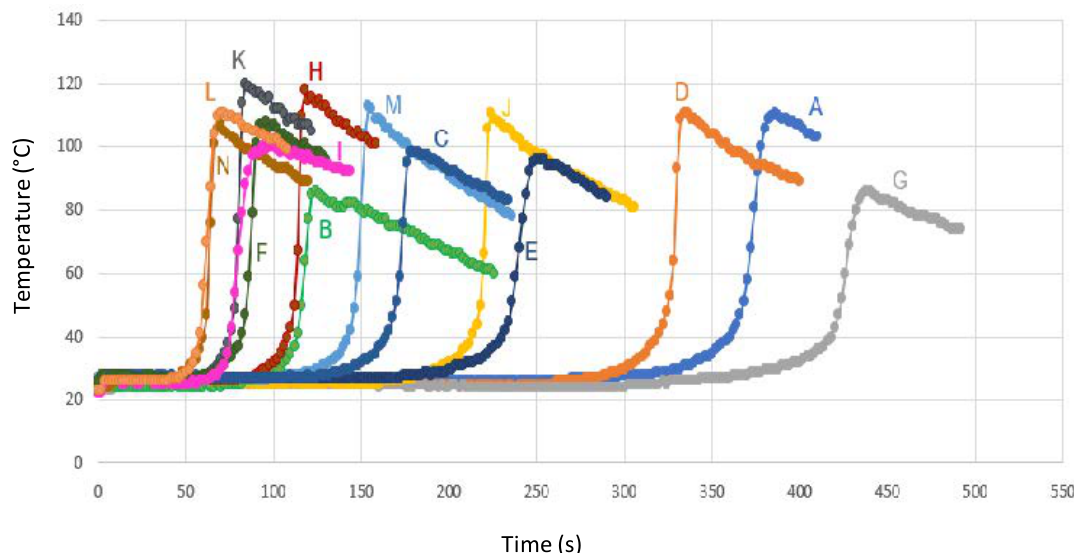
Figure 1. Optical pyrometric measurements (temperature vs. time after mixing; 4 mm thick sample) under air for the BM resin for Redox free radical polymerization (FRP) using different RISs: ( A ) T4epa/Iod (0.5%/1% w/w ); ( B ) T4epa/Iod (1%/2% w/w ); ( C ) T4epa/Iod (2%/0.5% w/w ); ( D ) T4epa/Iod (0.5%/1.5% w/w ); ( E ) T4epa/Iod (1.5%/0.5% w/w ); ( F ) T4epa/Iod (2%/1% w/w ); ( G ) T4epa/Iod (1%/0.5% w/w ); ( H ) T4epa/Iod (1.5%/1% w/w ); ( I ) T4epa/Iod (2%/1.5% w/w ); ( J ) T4epa/Iod (1%/1% w/w ); ( K ) T4epa/Iod (1.5%/1.5% w/w ); (L) T4epa/Iod (2%/2% w/w ); ( M ) T4epa/Iod (1%/1.5% w/w ); ( N ) T4epa/Iod (1.5%/2% w/w ).